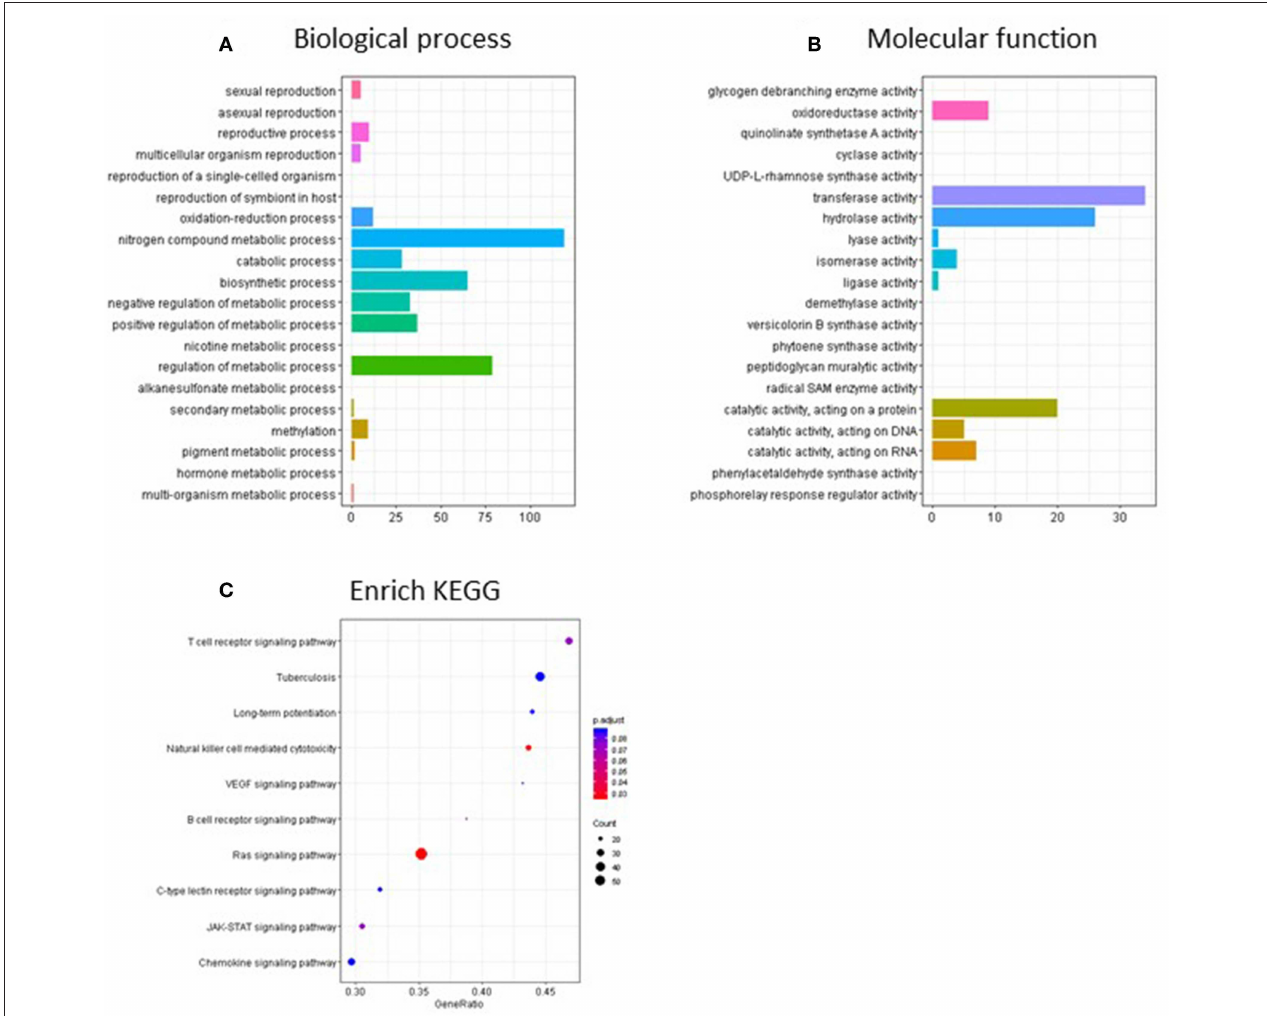
FIGURE 7 | Go terms and KEGG enriched pathways in the promoter regions of the continuous TCE group compared to control. GO terms overrepresentation analysis for (A) biological process and (B) molecular function of the significant promoter regions used the groupGO function of the clusterProfiler R package as described in the methods. (C) The KEGG pathway analysis was performed using clusterProfiler’s gseKEGG function with default